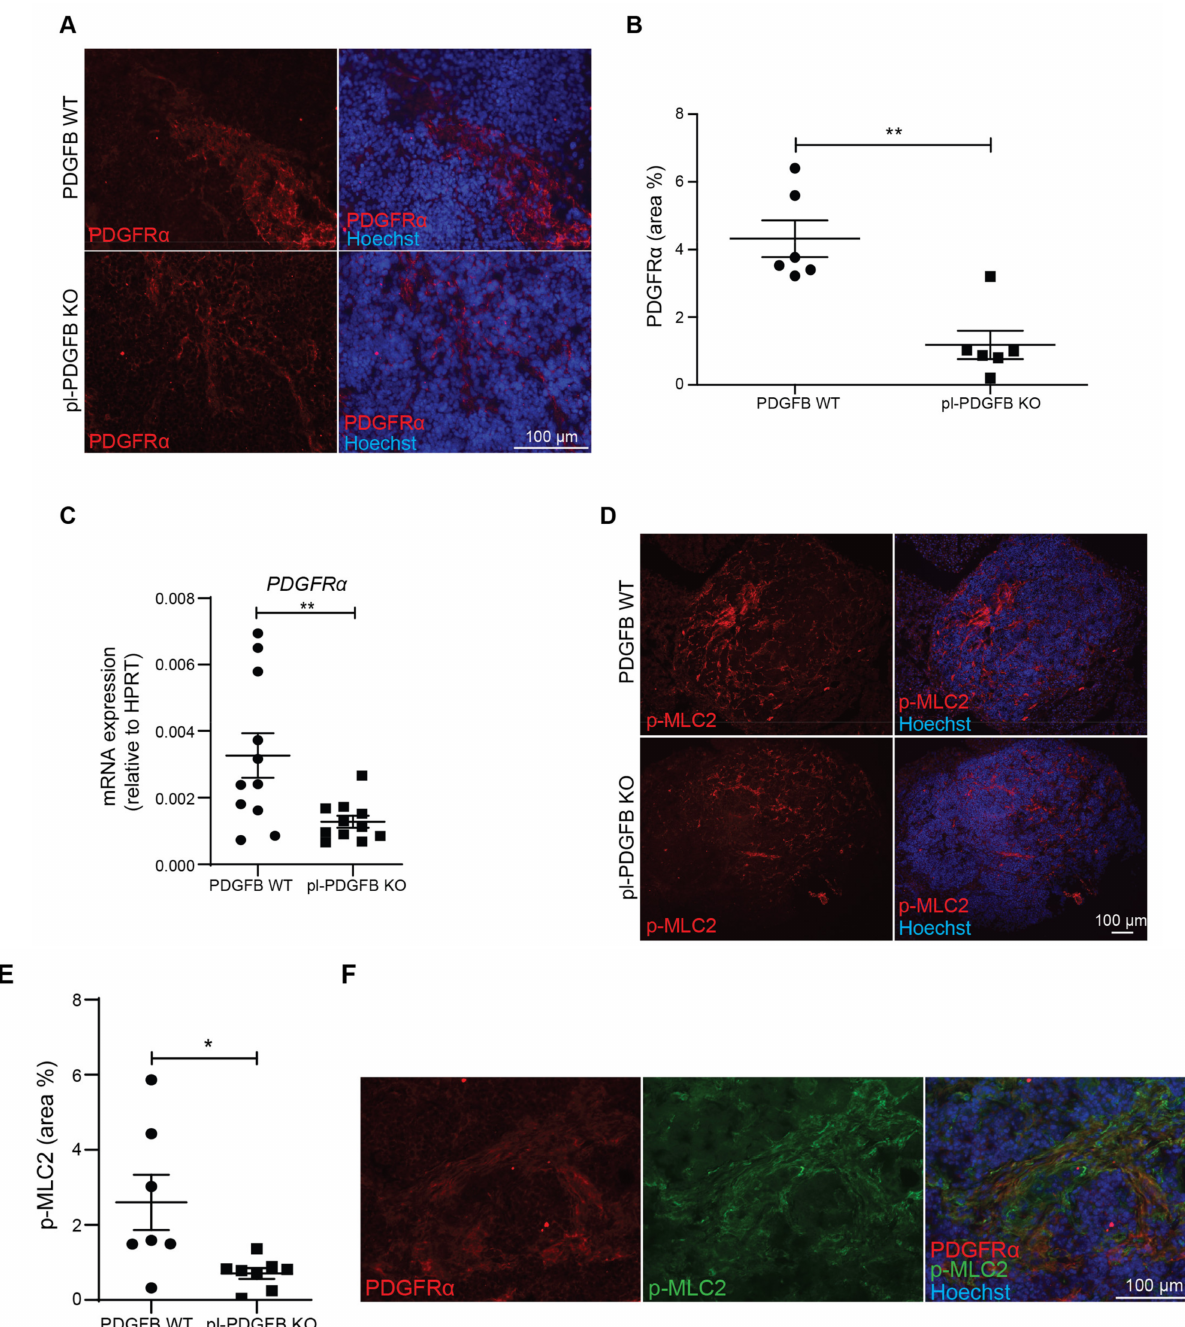
Figure 3. Fewer cancer-associated fibroblasts and reduced myosin light chain (MLC) phosphorylation in tumors from pl-PDGFB KO mice. ( A , B ) Tumor sections from 14-week old WT and pl-PDGFB KO RT2-positive mice were immunostained for PDGFR α ( n = 6/group, ** p = 0.0022) and the positive area quantified using Image J. ( C ) Expression of PDGFR α at the transcriptional level was analyzed by qPCR using RNA extracted from the same type of tumors as in panel A and B ( n = 11/group, ** p = 0.0095). ( D , E ) Tumor sections from 14-week old WT and pl-PDGFB KO RT2-positive mice were immunostained for phosphorylated MLC2 ( p -MLC2) (WT n = 7; KO n = 8, * p = 0.0184), and the positive areas quantified using Image J. ( F ) Co-staining of PDGFR α and p-MLC was performed on tumor tissue from 14-week old RT2-positive mice WT and pl-PDGFB KO mice. Error bars in the graphs represent the standard error of mean